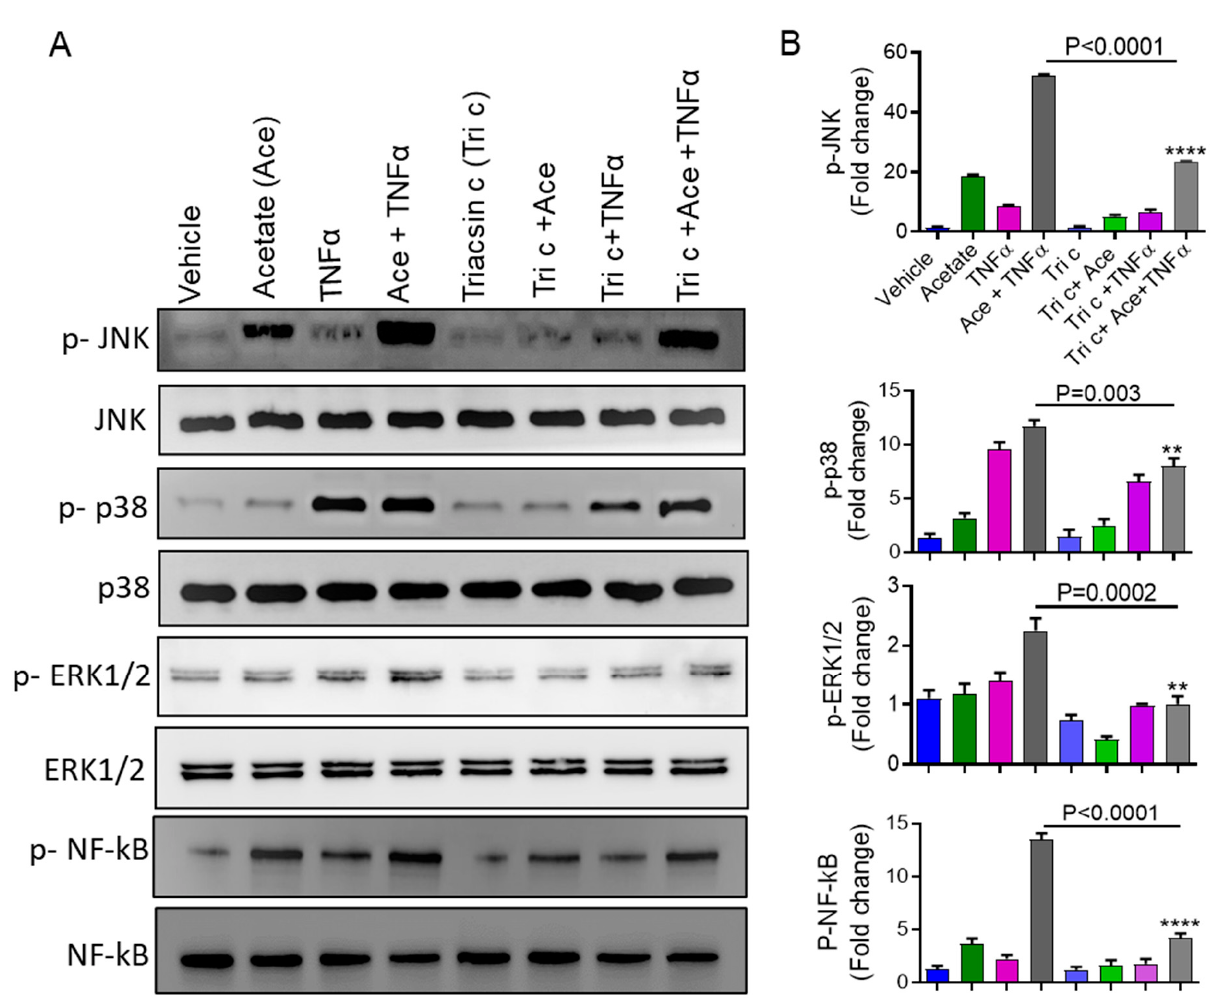
Figure 7. Impaired acetate/TNF α -induced activation of MAPK/NF- κ B in triacsin c pretreated cells. ( A ) Cells were preincubated with ACSL1 inhibitor triacsin c (4 uM) for 1 h and subsequently stimulated with acetate or TNF α or acetate/TNF α . The levels of phosphorylated MAPKs and NF- κ B were determined by Western blot. The corresponding Western blot for the total protein levels is depicted in the bottom panel. ( B ) Quantification of Western blot. The data are presented as mean ± SEM (n = 3). ** p < 0.01, **** p < 0.0001.